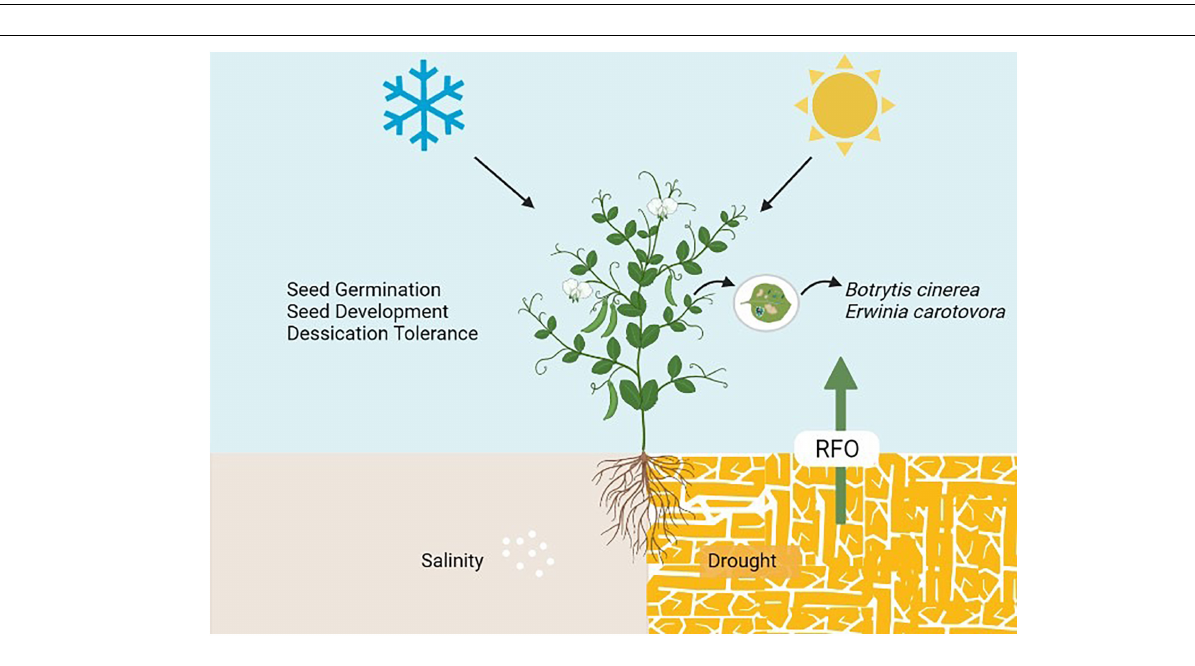
FIGURE 3 | Multi-functional role of RFOs in plant